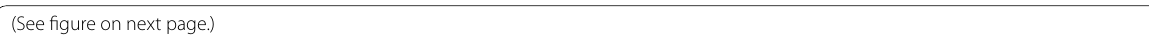
figure on next Fig. 4 Down-regulation of multiple proteins by miR-34a contributes to sensitization to TMZ. a miR-34a reduces protein levels of ATM, Bcl2, EGFR, UGCG and cMET. Representative western blot images show reduction in ATM, Bcl2, EGFR, UGCG and cMET protein levels in glioblastoma cells. Glioblastoma cells were transfected with 30 nM miR-34a or control miRNA, and cells were lysed 48 h later for protein analysis by western blotting. b Bcl2 siRNA reduces Bcl2 protein levels. Representative western blot images show reduction in Bcl2 protein levels in A172 glioblastoma cell line. A172 cells were transfected with two different Bcl2 siRNA or control siRNA at a concentration of 30 nM, and cells were lysed 48 h later for protein analysis by western blotting. c Inhibition of Bcl2 or cMet sensitizes to temozolomide. A172 cells were reverse-transfected with two different Bcl2 siRNAs, miR-34a and control miRNA 48 h prior to TMZ therapy or treated with JNJ-38877605 2 h prior to being treated with different concentrations of TMZ. Cell proliferation was determined by SRB. All data represent mean SRB values ( SD) from three independent experiments. d miR-34a ± transfection does not alter MGMT levels. Representative western blot images show reduction in cMET, being used as a positive control, while MGMT protein levels are not affected by miR-34a transfection in the T98G and GBM6 glioblastoma cell cultures. T98G cells were transfected and analyzed similarly to A172 cells in (A). GBM6 cells were transduced with a lentivirus, overexpressing miR-34a only upon doxycycline induction. miR-34a expression was induced in GBM6 cultures for 72 h after which cells were lysed for protein